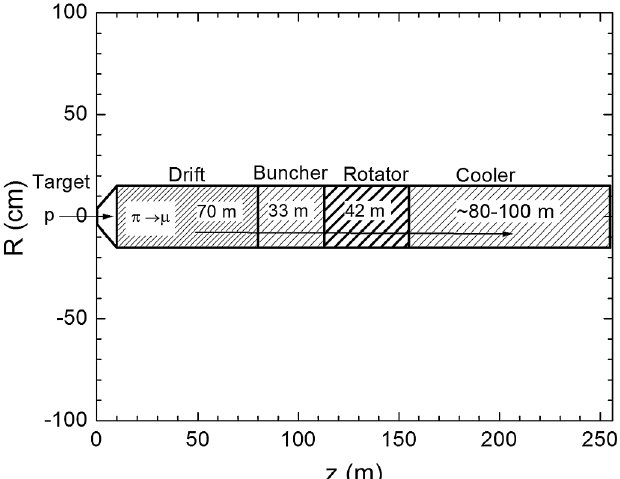
FIG. 1. Schematic representation of the front-end system of a neutrino factory, showing a target, a drift, an rf buncher, a phase- energy rotator, and a cooler section. Pions are produced by protons on a target at the beginning of the drift, decay to muons in the drift, and while lengthening in phase, the buncher and rotator change the muons into a string of bunches with nearly equal